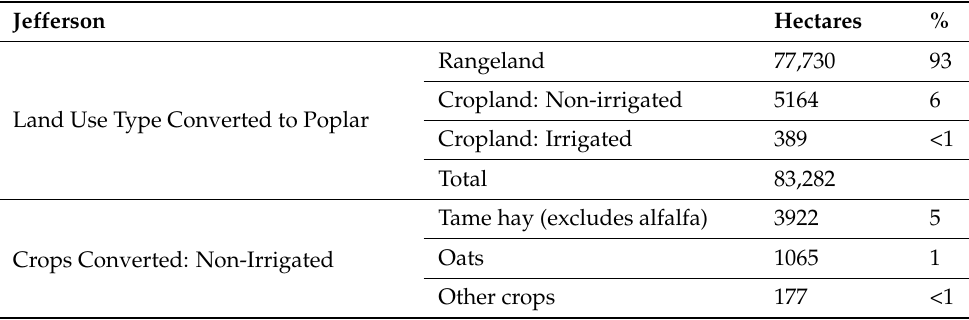
Table 3. Jefferson land use and crop types converted to growing poplar. ‘Other crops’ are crops that individually represented less than 1% of the land used to grow crops. Percentage column is based on total land use types converted to growing